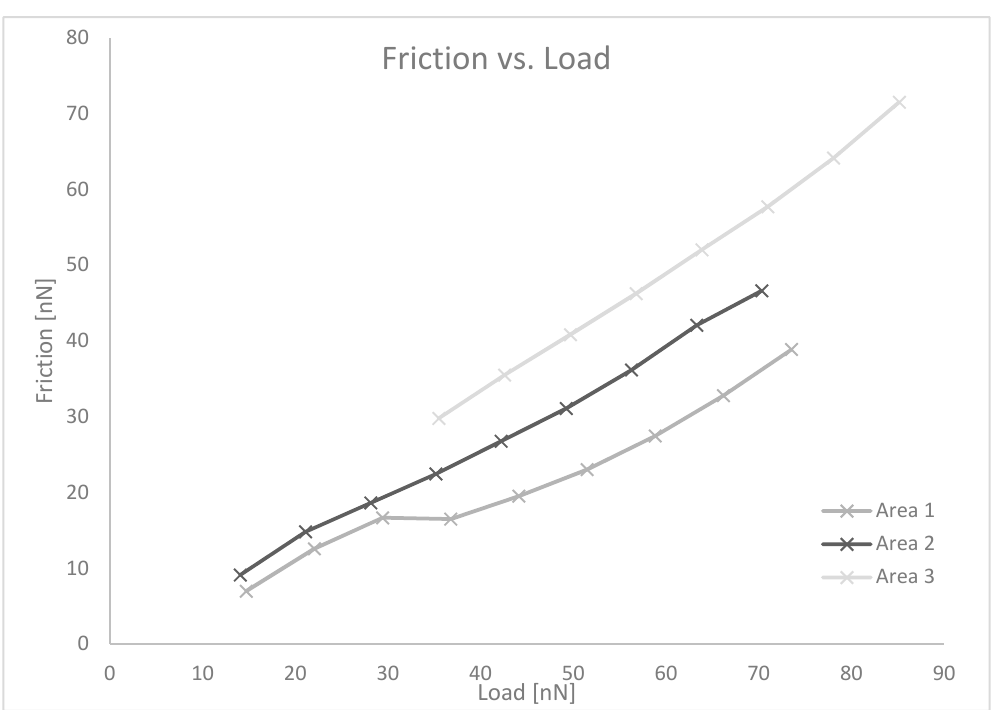
Figure 6. Atomic force microscope (AFM).